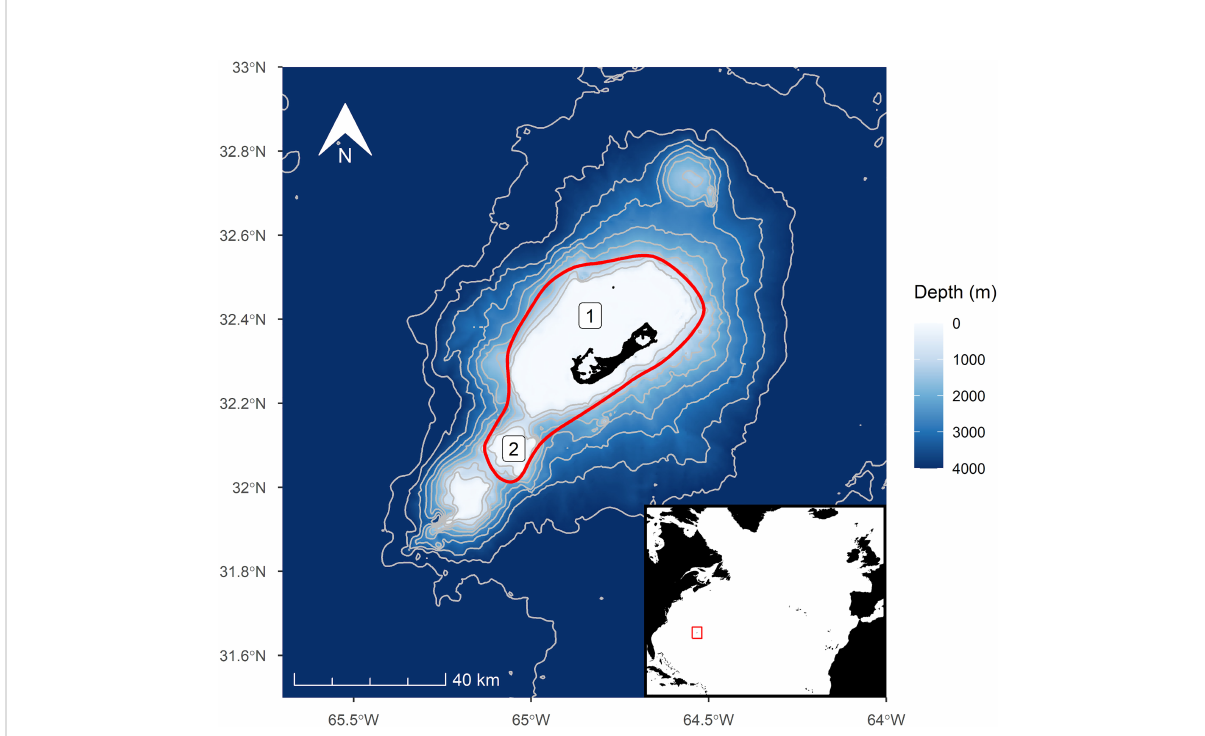
FIGURE 1 Map of the study area, the waters around Bermuda, and its position within the North Atlantic (inset). The approximate search area is denoted by the red line. The study area encompasses two major bathymetric features, 1) the Bermuda Platform and 2) Challenger